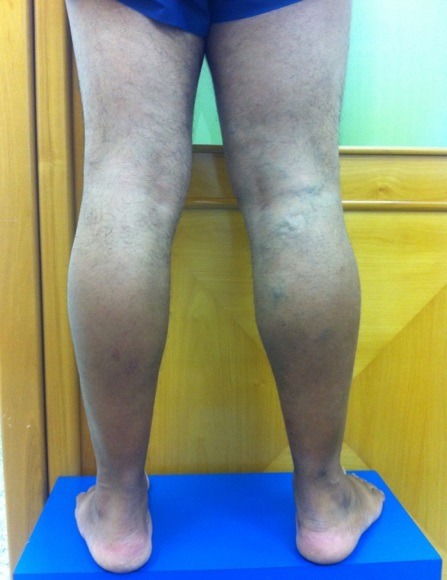
Lower limbs with patient standing upright, rear view, showing varicose veins in proximal leg.